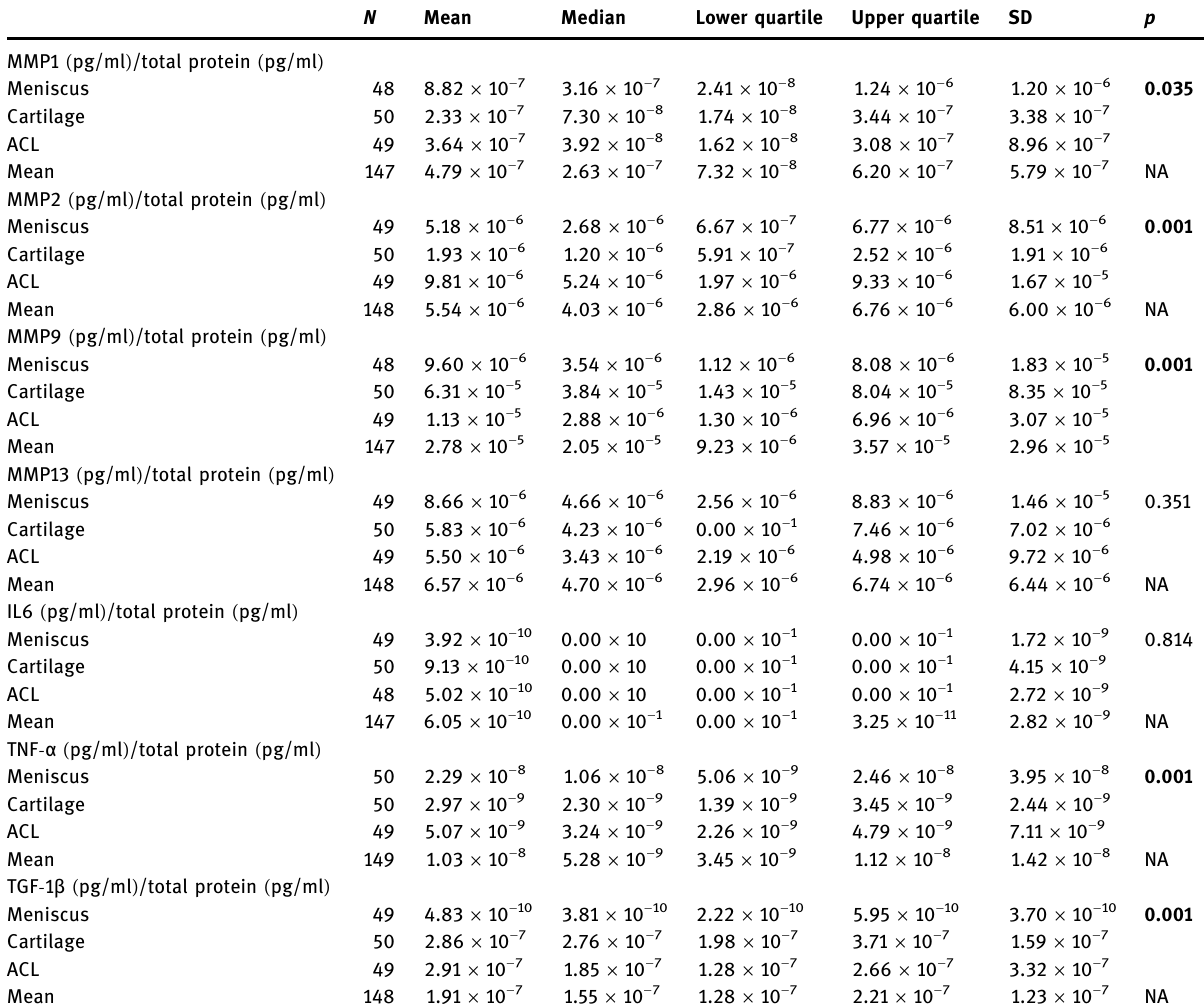
Table 2: Concentration of investigated proteins corrected with respect to overall protein concentration in anatomical structures N Mean